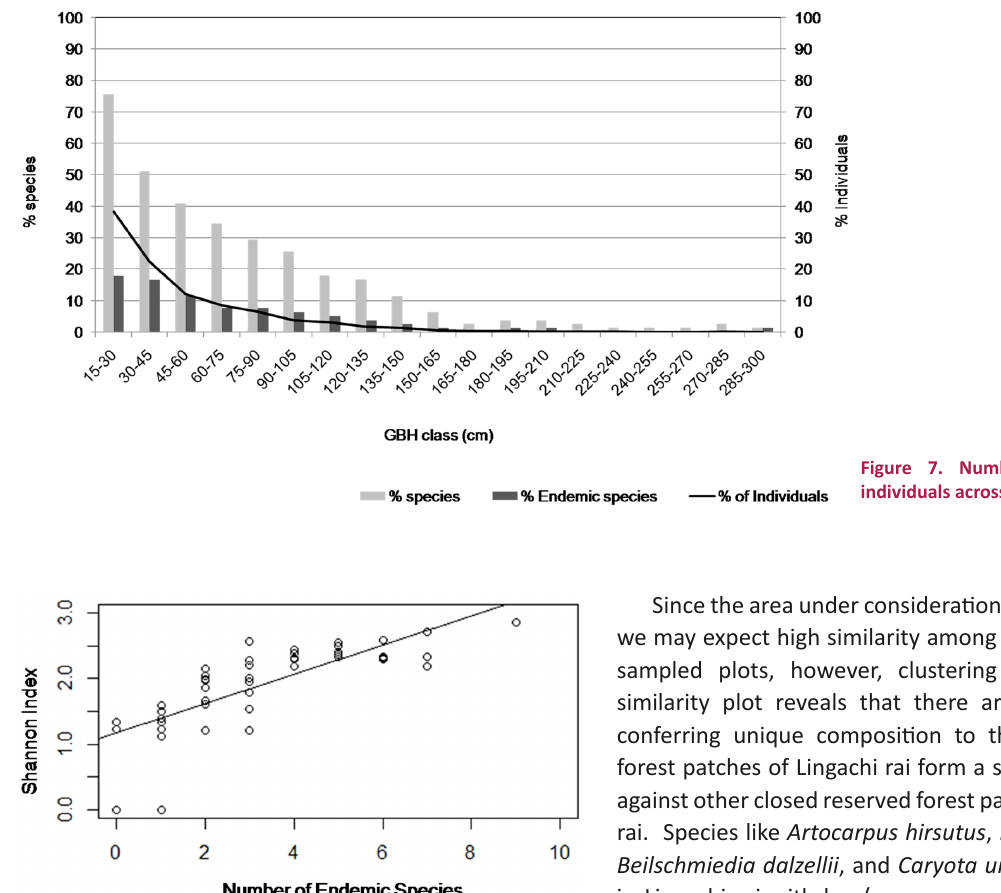
Figure 8. Relation between endemic species richness and Shannon